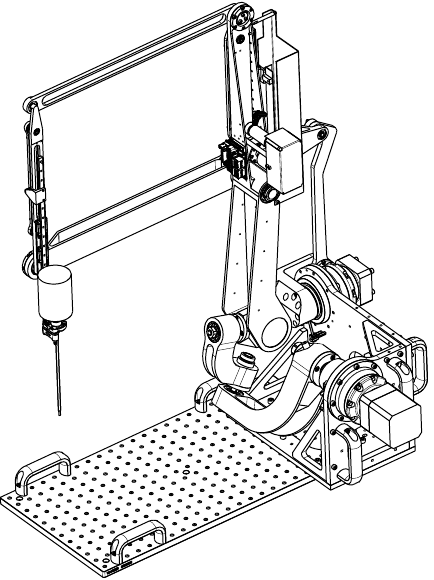
Figure 4. Prototype of the robot with an